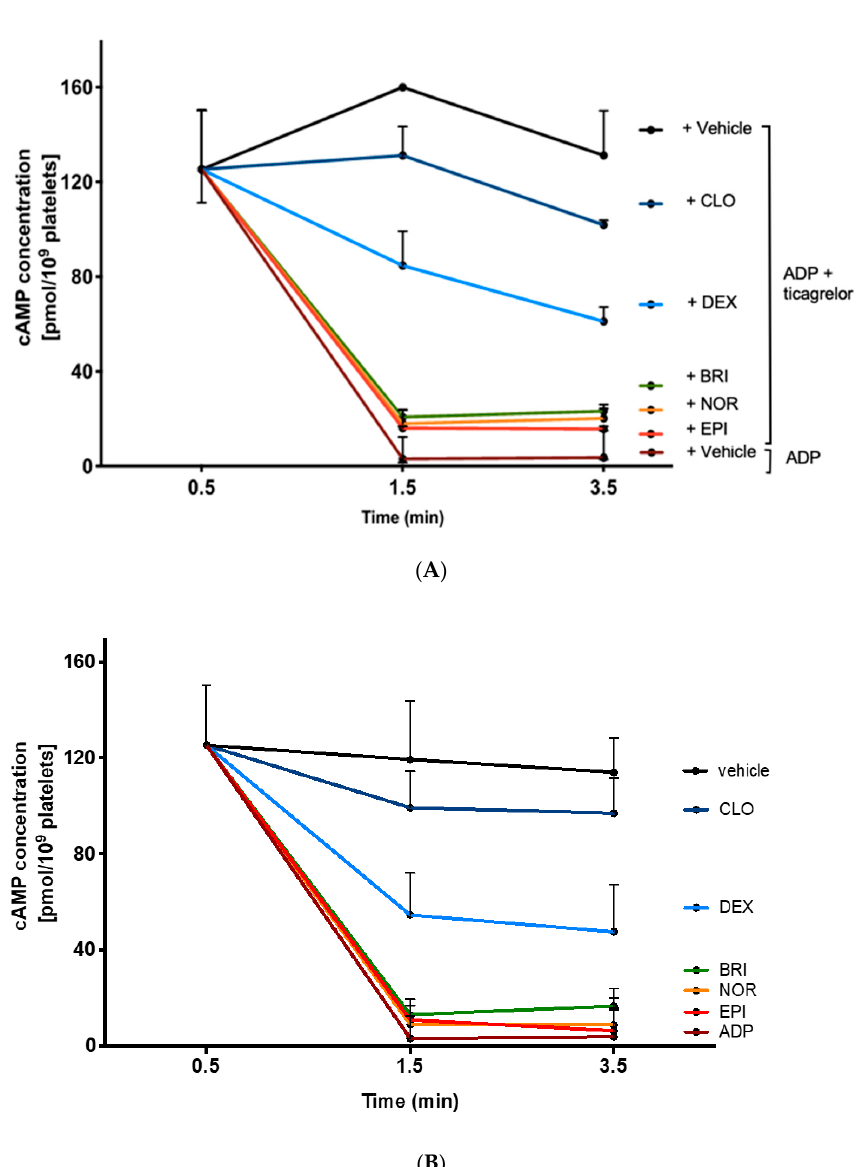
Figure 4. Norepinephrine and brimonidine fully inhibit PGE1-stimulated cAMP production whereas clonidine and dexmedetomidine induce only weak inhibition. Comparison of cAMP level of washed platelet pre-incubated with PGE1 for 0.5 min and then stimulated with ( A ) ADP alone, or a combination of ADP and clonidine (CLO), dexmedetomidine (DEX), brimonidine (BRI), norepinephrine (NOR), or epinephrine (EPI), in the presence of ticagrelor and with ( B ) ADP or α 2 -adrenoreceptor agonists, in the absence of ticagrelor. cAMP assays were performed on samples taken before (time 0.5 min), or 1 min and 3 min (time 1.5 min and 3.5 min) after the addition of the agonists or vehicle. Results are expressed in the median with ranges ( n =